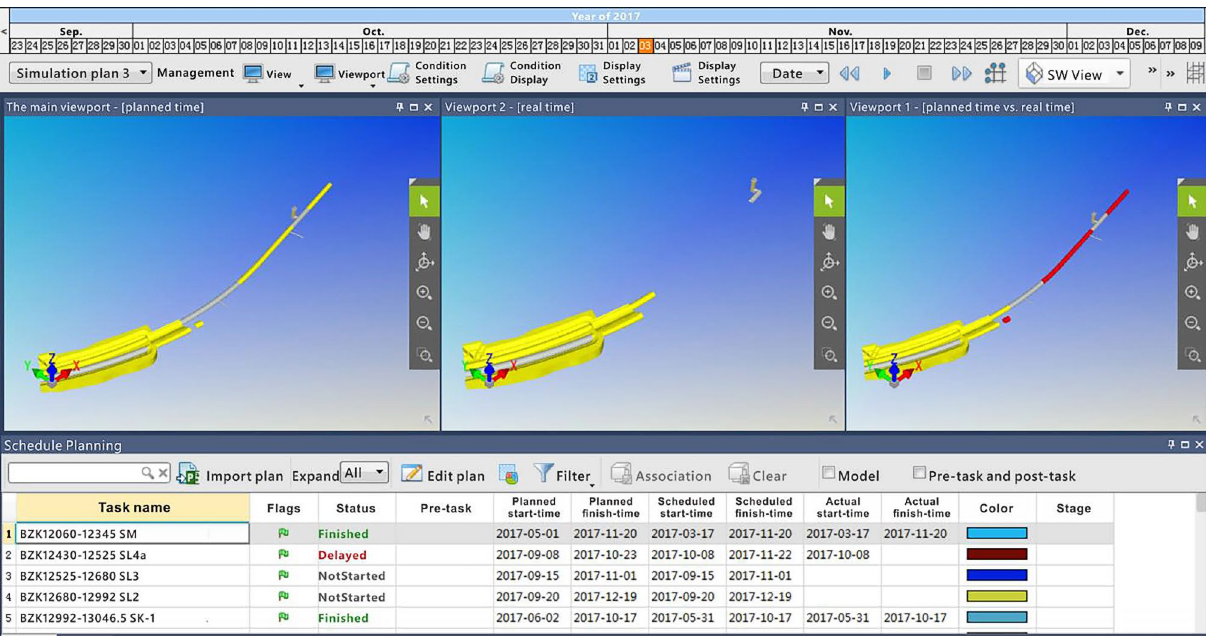
Figure 10. Simulation of the construction process using BIM 4D can realize the management of the time limit of the